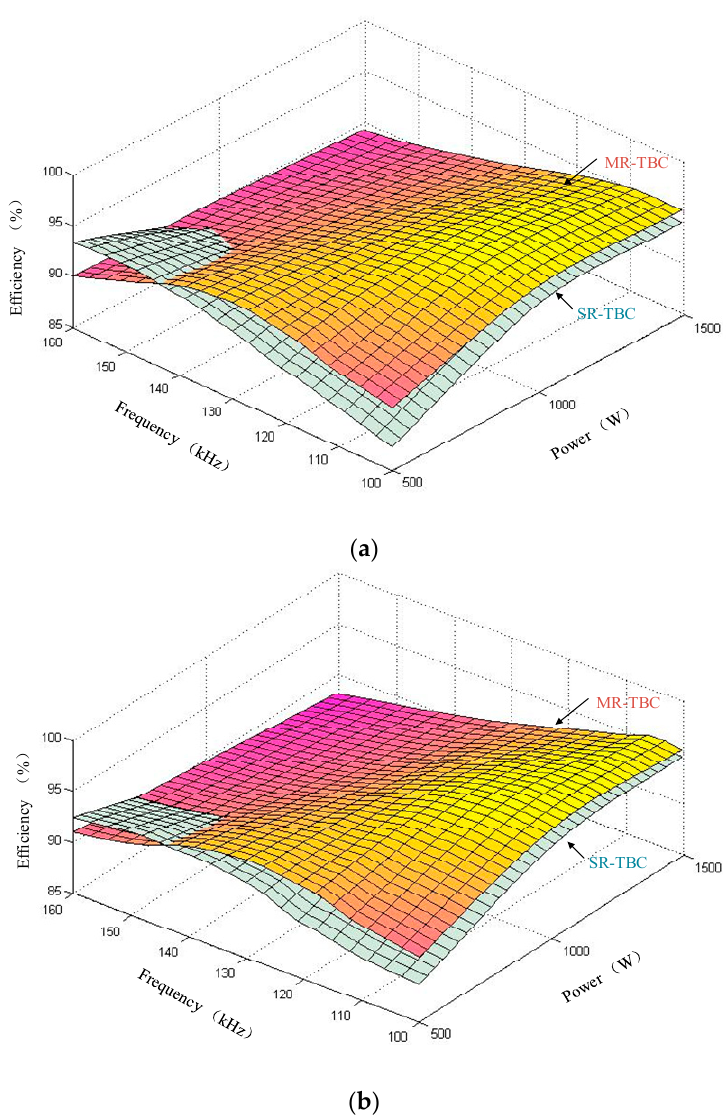
Figure 17 . Efficiency three -dimensional graph of MR-TBC and SR-TBC ( a ) forward; ( b ) reverse. Figure 17. Efficiency three-dimensional graph of MR-TBC and SR-TBC ( a ) forward; ( b )